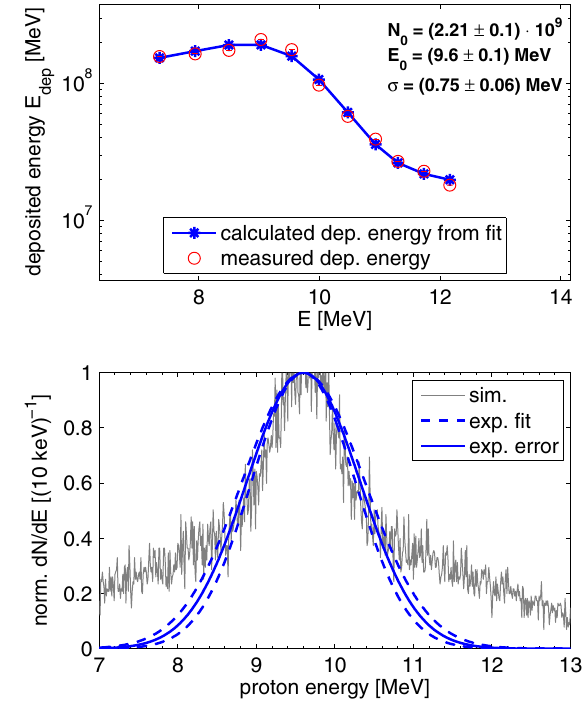
FIG. 3. Deposited energy in the RCFs when focusing 9.6 MeV at 3 m to the laser target. A Gaussian spectral distribution with an energy width of σ ¼ ð 0 . 72 (cid:1) 0 . 06 Þ MeV [compare Eq. (1)] can be deduced by deconvolution. The calculated deposited energy from such a Gaussian distribution fits the measured deposited energy very